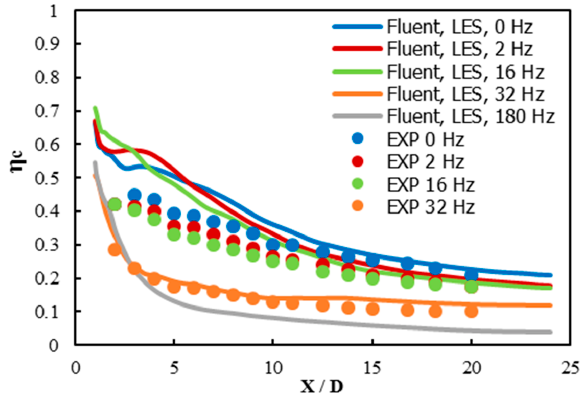
Figure 14. The centerline effectiveness obtained using the LES Smagorinsky–Lilly model for M = 0.5 for the 0, 2, 16, 32, and 180 Hz oscillations.